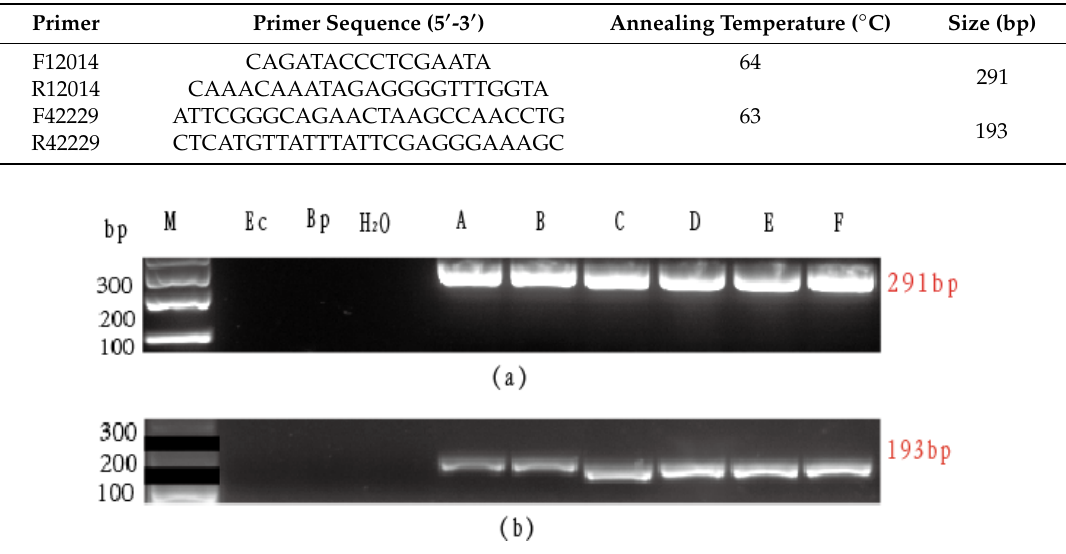
Figure 2. Agarose gel showing the amplification profiles obtained for the two sets of primers tested 12,014 ( a ) and 42,229 ( b ) in the negative controls E. coioides (Ec) and B. pectinirostris (Bp); in the blank control (H2O); and in G. morhua -1 ( A ); G. morhua -2 ( B ); R. hippoglossoides -1 ( C ); R. hippoglossoides -2 ( D ); D. eleginoide -1 ( E ); D. eleginoide -2 ( F ) samples. Table 3. Two sequences that contain SNPs were chosen for identifying three cod